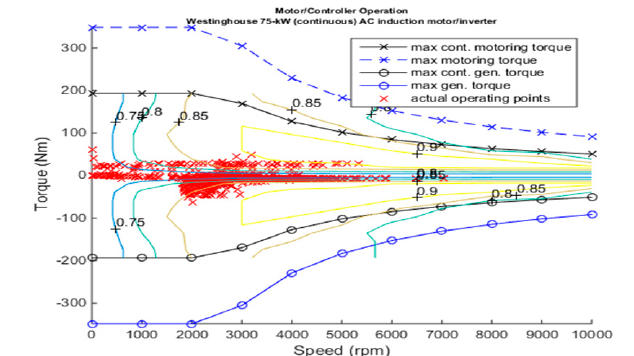
Figure 11. Motor torque-speed.